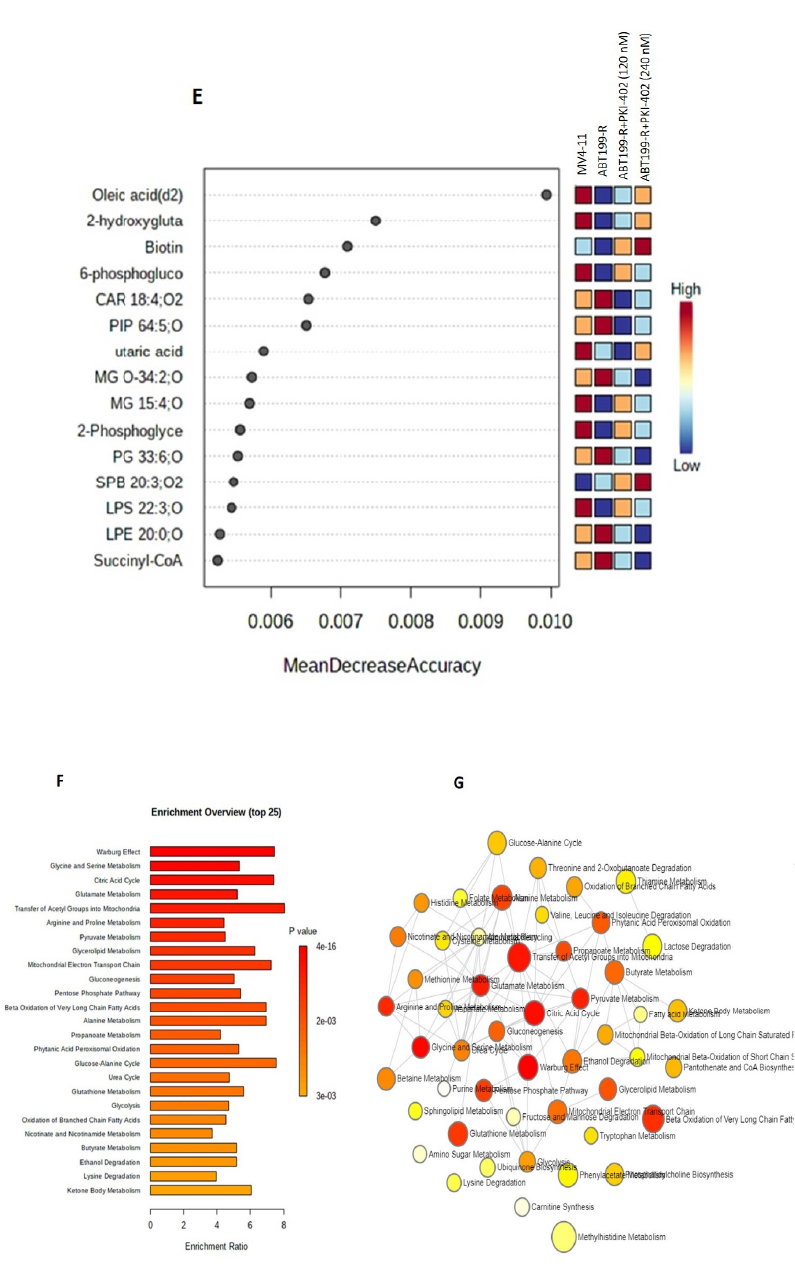
Figure 3. Metabolomic analysis of MV4-11, ABT199-R, and ABT199-R treated with PKI-402. ( A ) Metabolites were extracted and run in LTQ-XL linear ion trap LC-MS, showing their total ion chromatograms. ( B ) PCA analysis of comprehensive metabolites of MV4-11 cells, ABT199-R cells, and ABT199-R cells treated with PKI-402. ( C ) Correlation heatmap of ABT-199R cells, MV4-11 cells, and ABT199-R cells treated with PKI-402. ( D ) Heatmap of differentially expressed metabolites in MV4-11 cells, ABT199-R cells, and ABT199-R cells treated with PKI-402. ( E ) VIP score based on PCA analysis of principal metabolites. ( F ) Top pathway enriched in metabolome analysis in MV4-11 cells, ABT199-R cells, and ABT199-R cells treated with PKI-402. ( G ) Pathway network analysis.